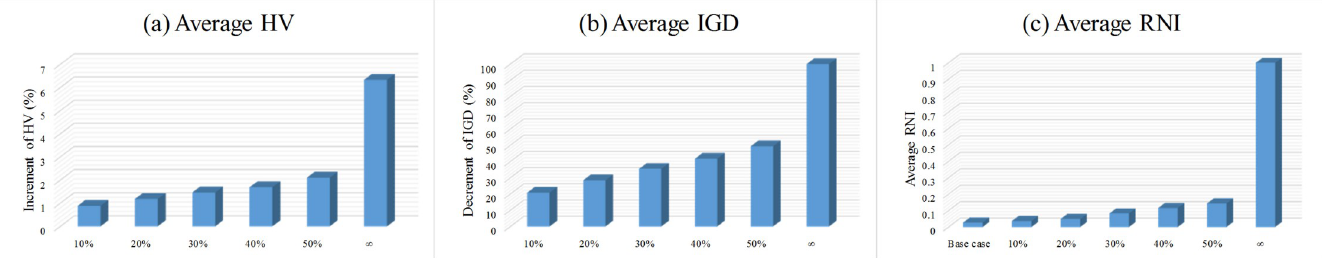
Fig 9. Effects of hard time windows on the performance indicators (only HV, IGD, and RNI).